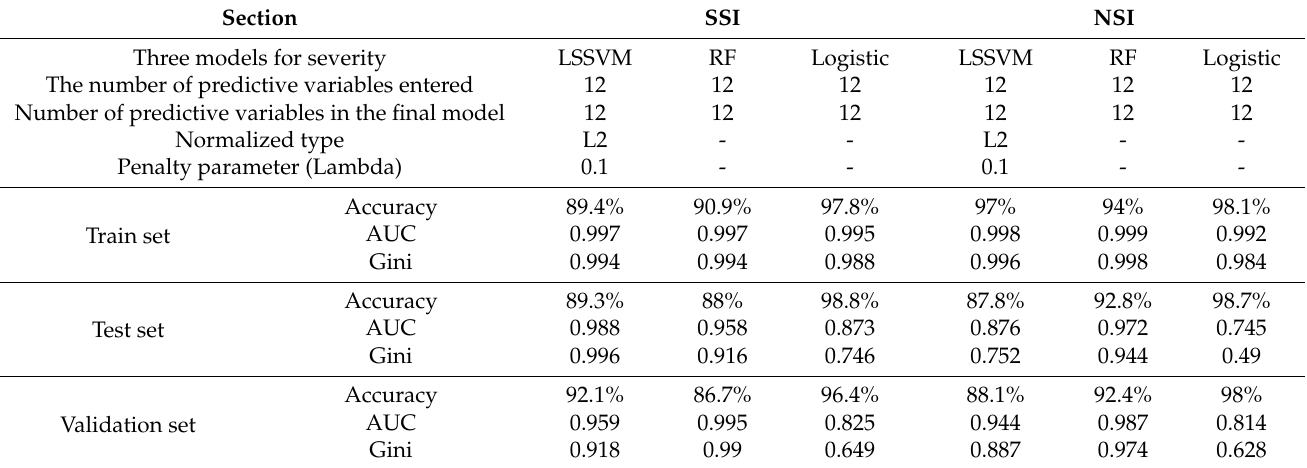
Table 5. Parameters related to the three